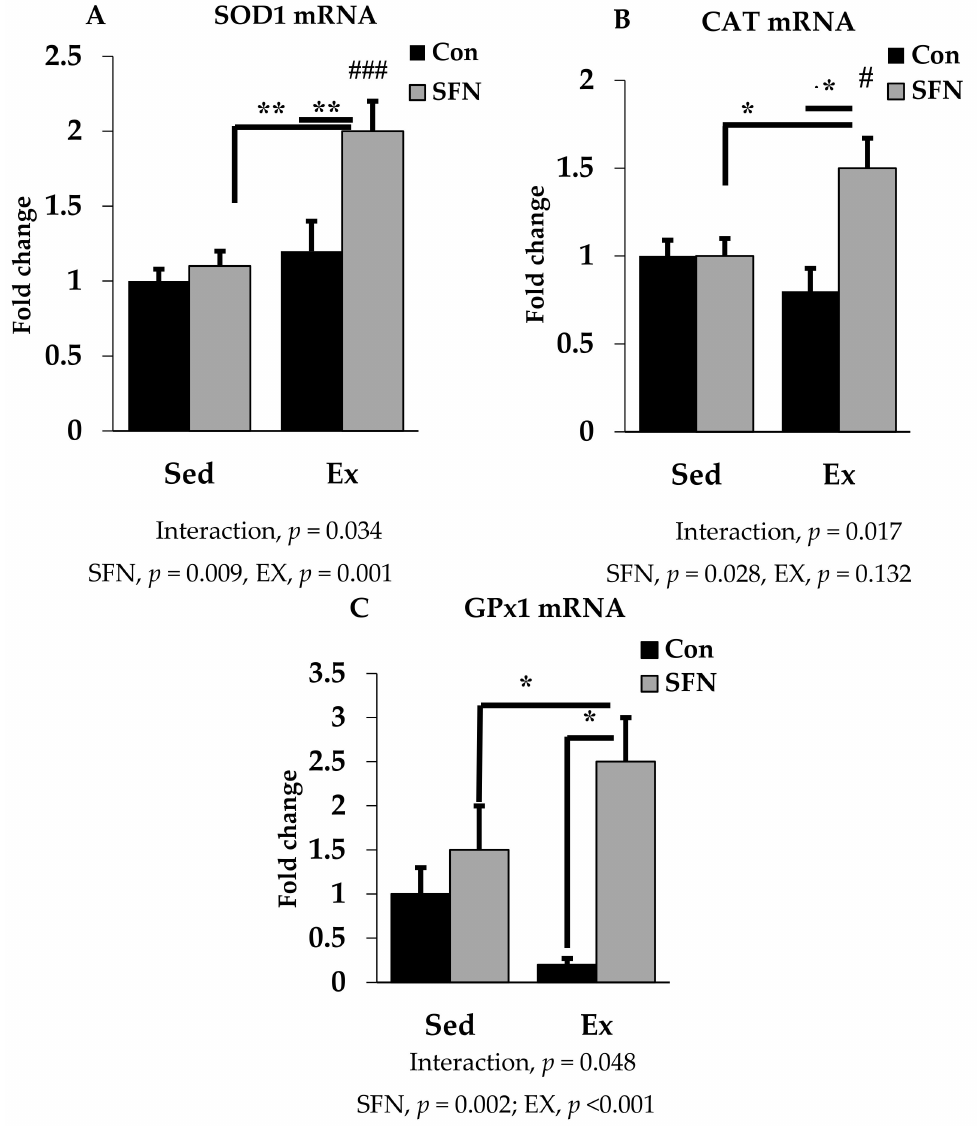
Figure 4. Superoxide dismutase 1 (SOD1) mRNA ( A ), Catalase (CAT) mRNA ( B ), and Glutathione peroxidase 1 (GPx1) mRNA ( C ) expression in the liver in the comparison between the sedentary (Sed) and exercise (Ex) groups, with (sulforaphane; SFN) or without (control; Con) supplement. ### p < 0.001, # p < 0.05 as compared to the sedentary control. ** p < 0.01, * p < 0.05. Interaction of SFN and Ex written as “Interaction”. Data are presented as mean ±